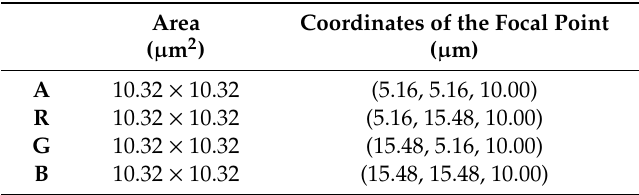
Table 2. Design parameters of four areas with equal proportions.